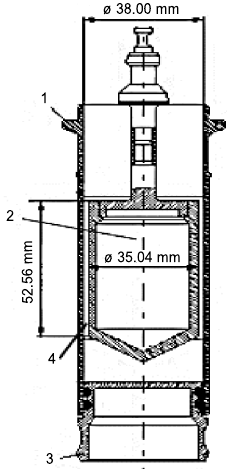
Fig. 1. Principle scheme of testing